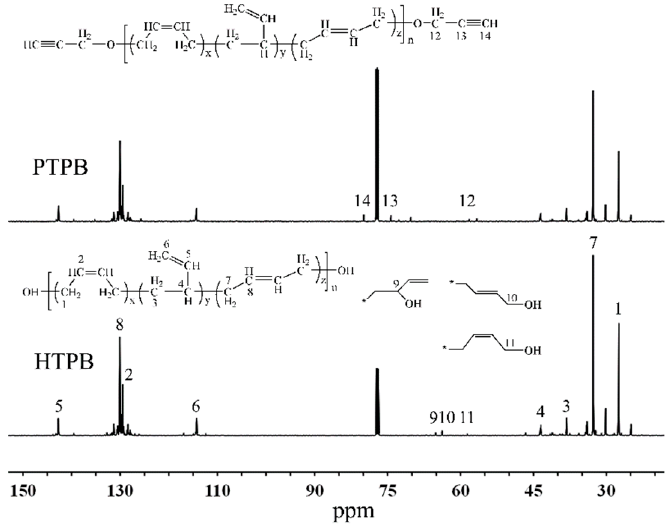
Figure 2. The 13 C NMR spectra for HTPB and PTPB.